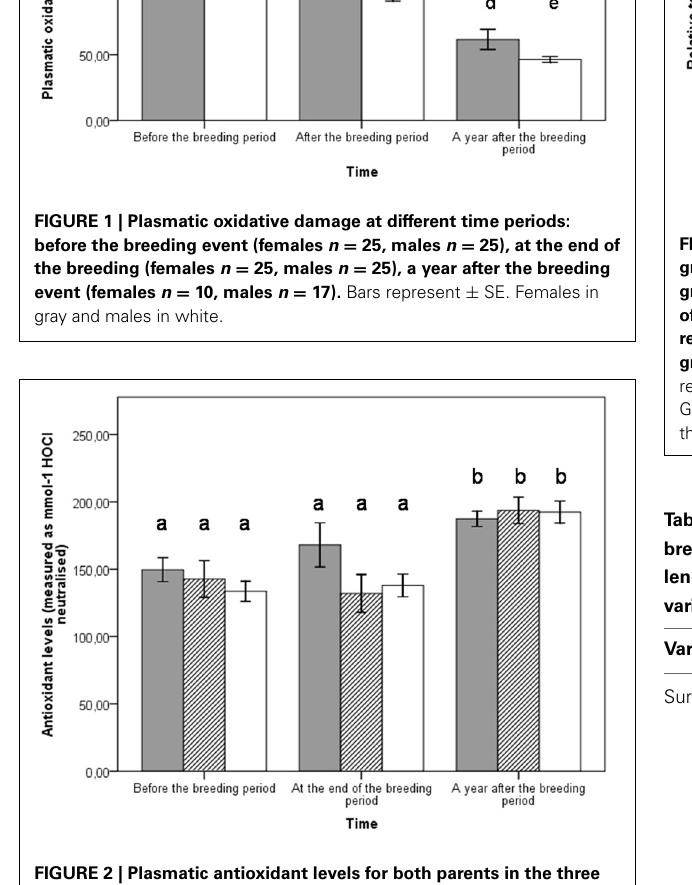
FIGURE 2 | Plasmatic antioxidant levels for both parents in the three different groups at different time periods: before the breeding event (enhanced group n = 18, control group n = 18, reduced group n = 14), at the end of the breeding event (enhanced group n = 18, control group n = 18, reduced group n = 14), a year after the breeding event (enhanced group n = 10, control group n = 6, reduced group n = 11). Bars represent ± SE. Enhanced in gray, control in hatched, reduced in white.